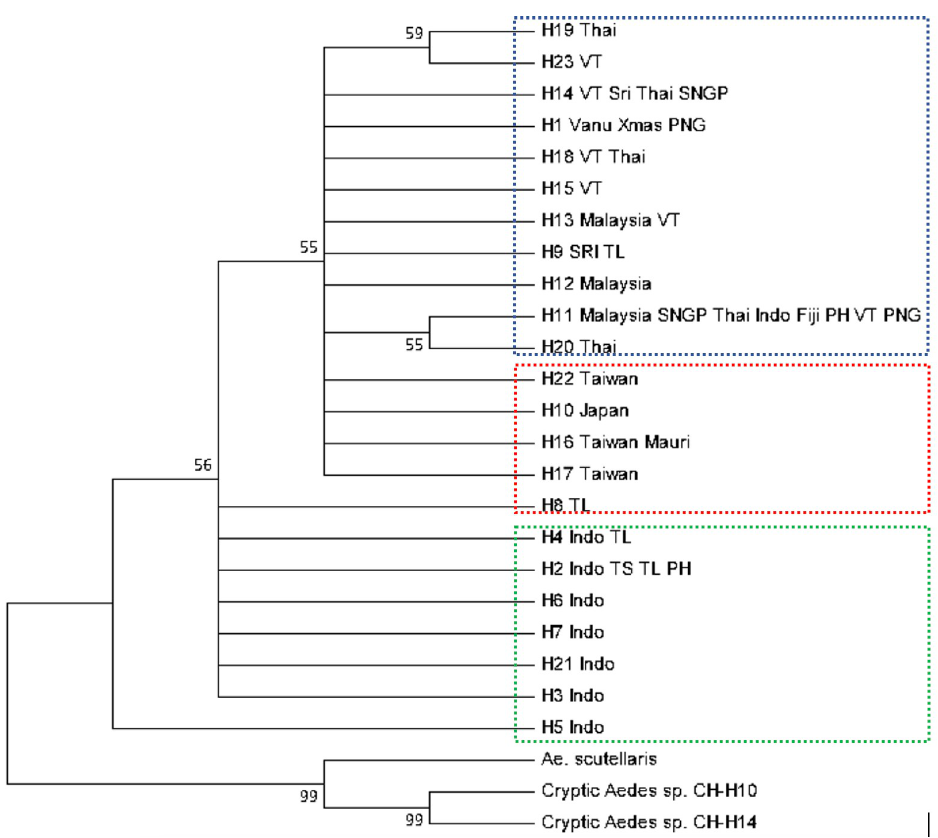
Fig 3. Phylogenetic analysis based on CO1 haplotype variation. Neighbor-joining trees constructed via Kimura-2 parameter model using MEGA. Numbers at branches represent bootstrap values of 1000 replicates (values > 50 are shown). Sequences from different outgroup species of the genus Aedes were selected from GenBank ( Ae . albopictus cryptic haplotypes KY765450.1 and KY765459 and Ae . scutellaris KP843372). Abbreviations: Thai, Thailand;